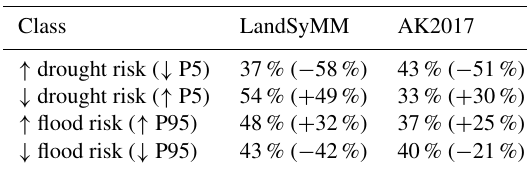
Table 2. Fraction of land with changing drought and/or flood risk between the last three decades of the 20th and 21st centuries in SSP5-85. Numbers in parentheses give each group’s mean percent change in runoff. LandSyMM results have been aggregated to basin scale. AK2017: Asadieh and Krakauer